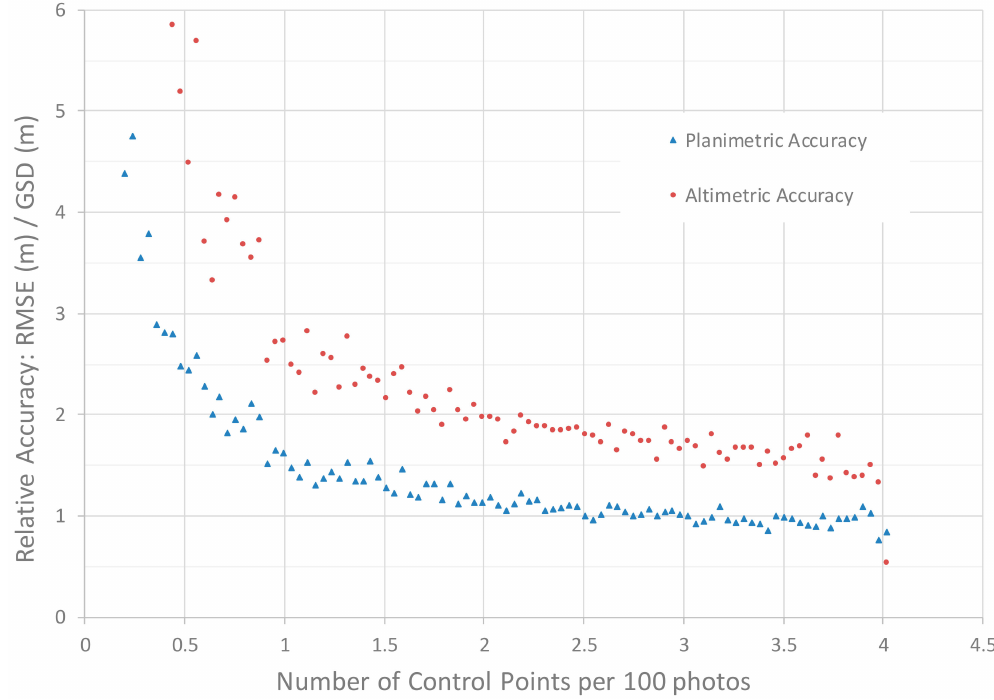
Figure 9. Accuracy at check points versus the “number of control points per 100 photos” used in the project. The obtained fit is specific to this case